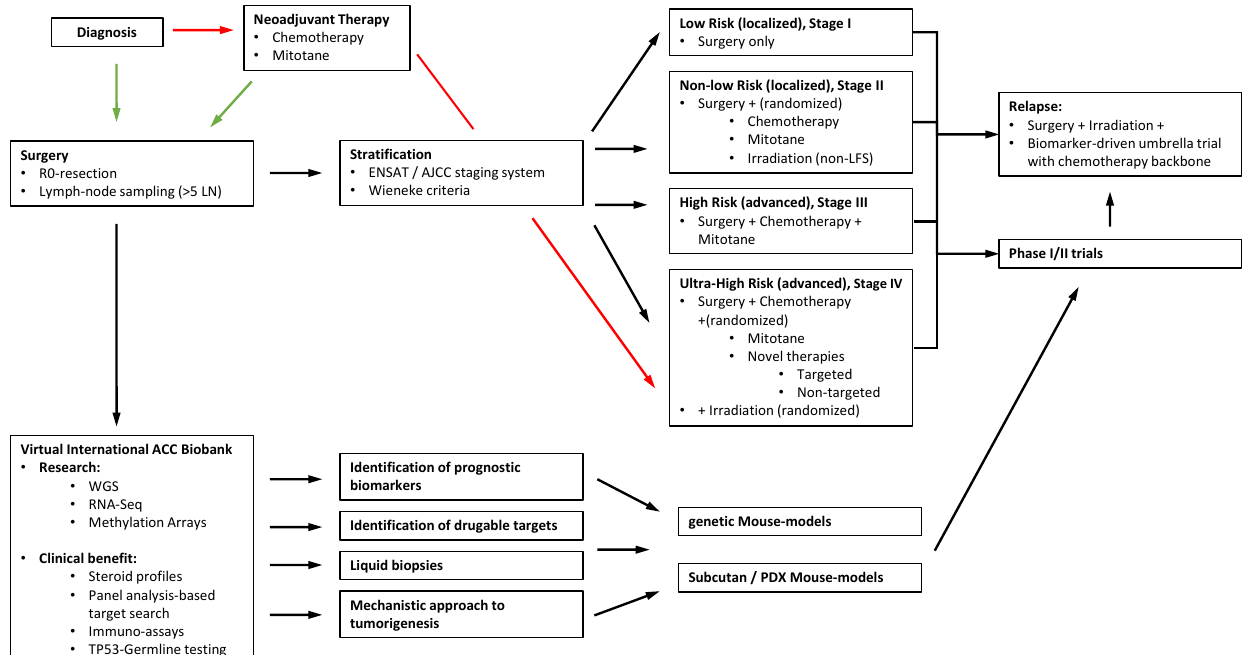
Figure 3. Recommended approach and treatment algorithm for a possible study design. Standardized consensus guidelines on surgery, stratification, and further treatments lead to randomized trials and are embedded in an integrative strategy including modern biobanking allowing preclinical in vitro and murine model studies as well as a set-up of phase I/II trials for novel targeted